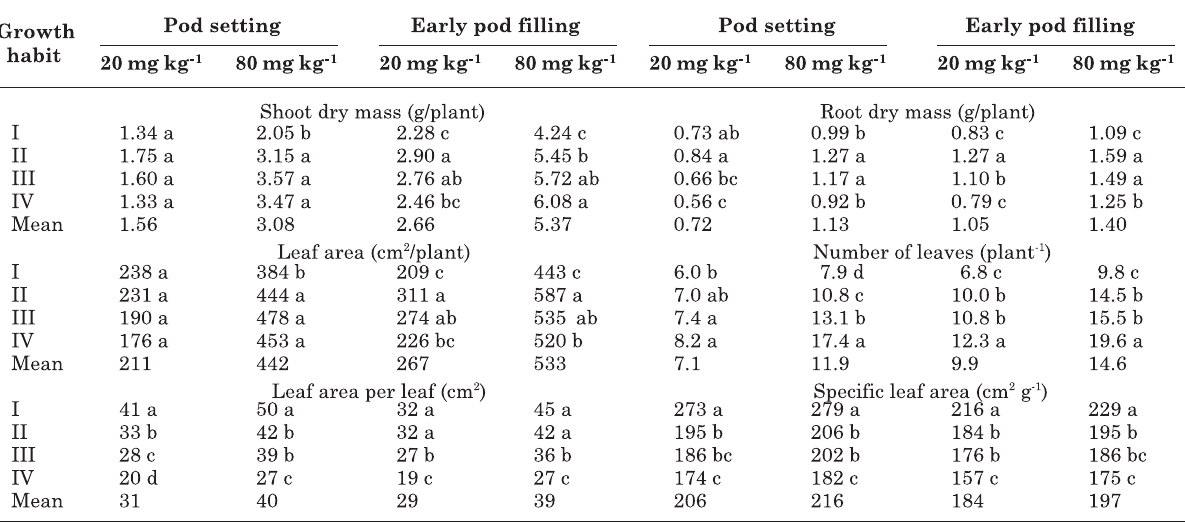
Means followed by the same letter within a column do not differ by Tukey test 5 %.